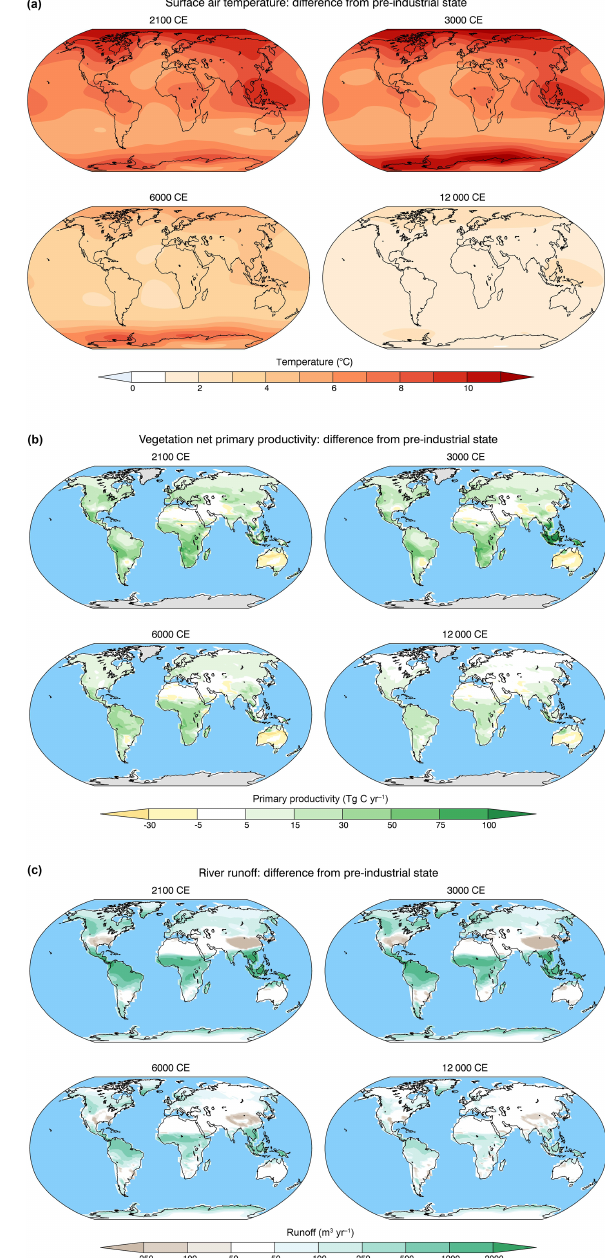
Figure 4. Spatial distribution of changes in (a) surface air temper- ature; (b) vegetation net primary productivity; and (c) river runoff for experiment A0 from pre-industrial (year 1800 CE) state to years 2100, 3000, 6000, and 12000CE. Nonlinear color scales are used in (b) and (c) to better display the results for the later stages of the model